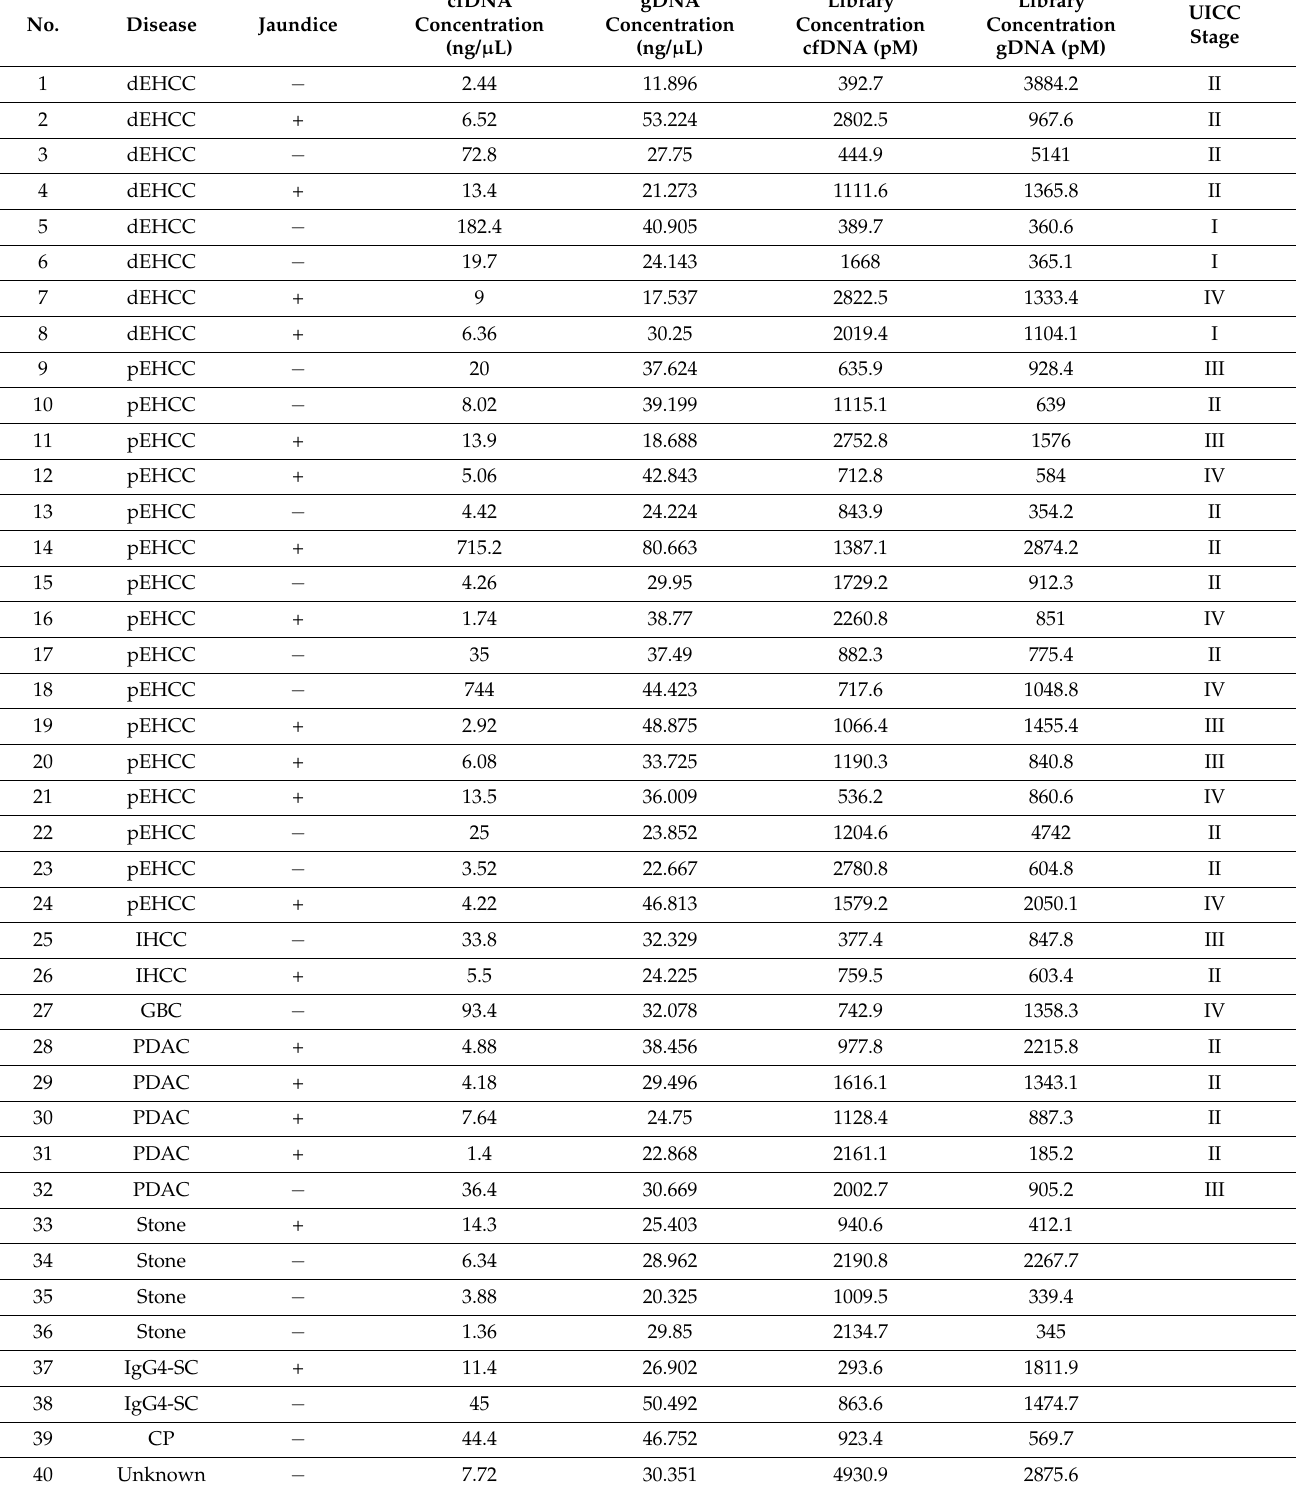
Table 4. Concentrations of cfDNA, genomic DNA (gDNA) and library in the bile